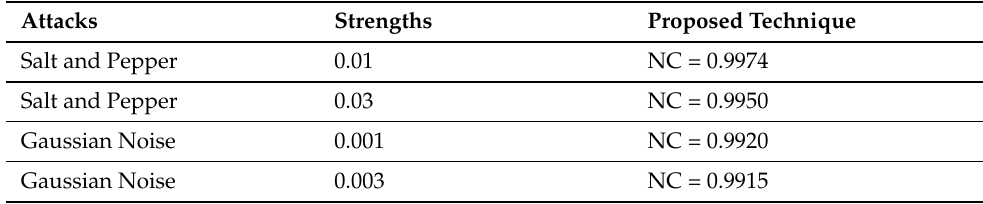
Table 4. Normalized correlation against image processing